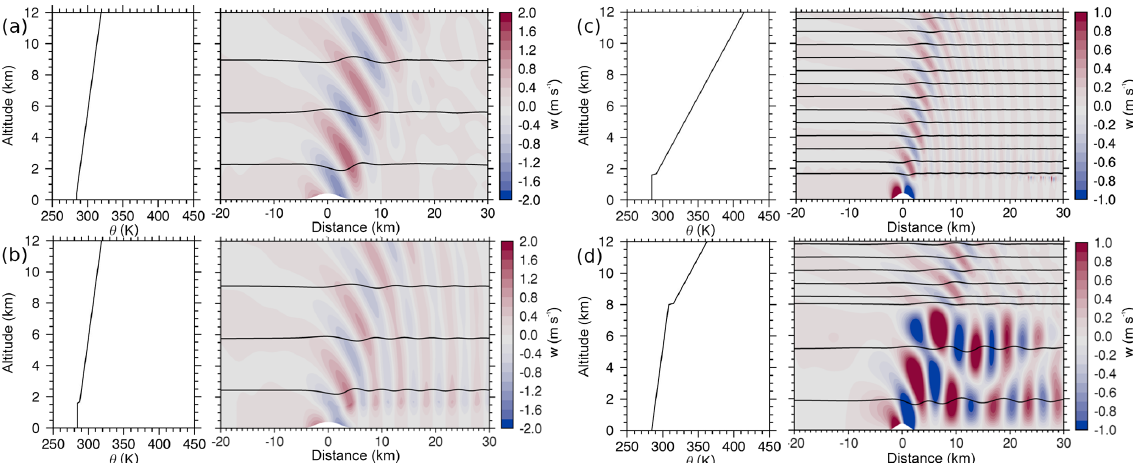
Figure 11. Potential temperature and vertical velocity of the idealized simulations of the cases with (a) a neutral boundary layer without inversion and N U = 0 . 01s − 1 (run 1), (b) a neutral boundary layer with an inversion of 3.3K and N U = 0 . 01s − 1 (run 2), (c) a neutral boundary layer with an inversion of 6.6K and N U = 0 . 02s − 1 (run 3), and (d) a stable troposphere ( N = 0 . 01s − 1 ) with a TIL of 6.6K and N U = 0 . 02s − 1 (run 4).